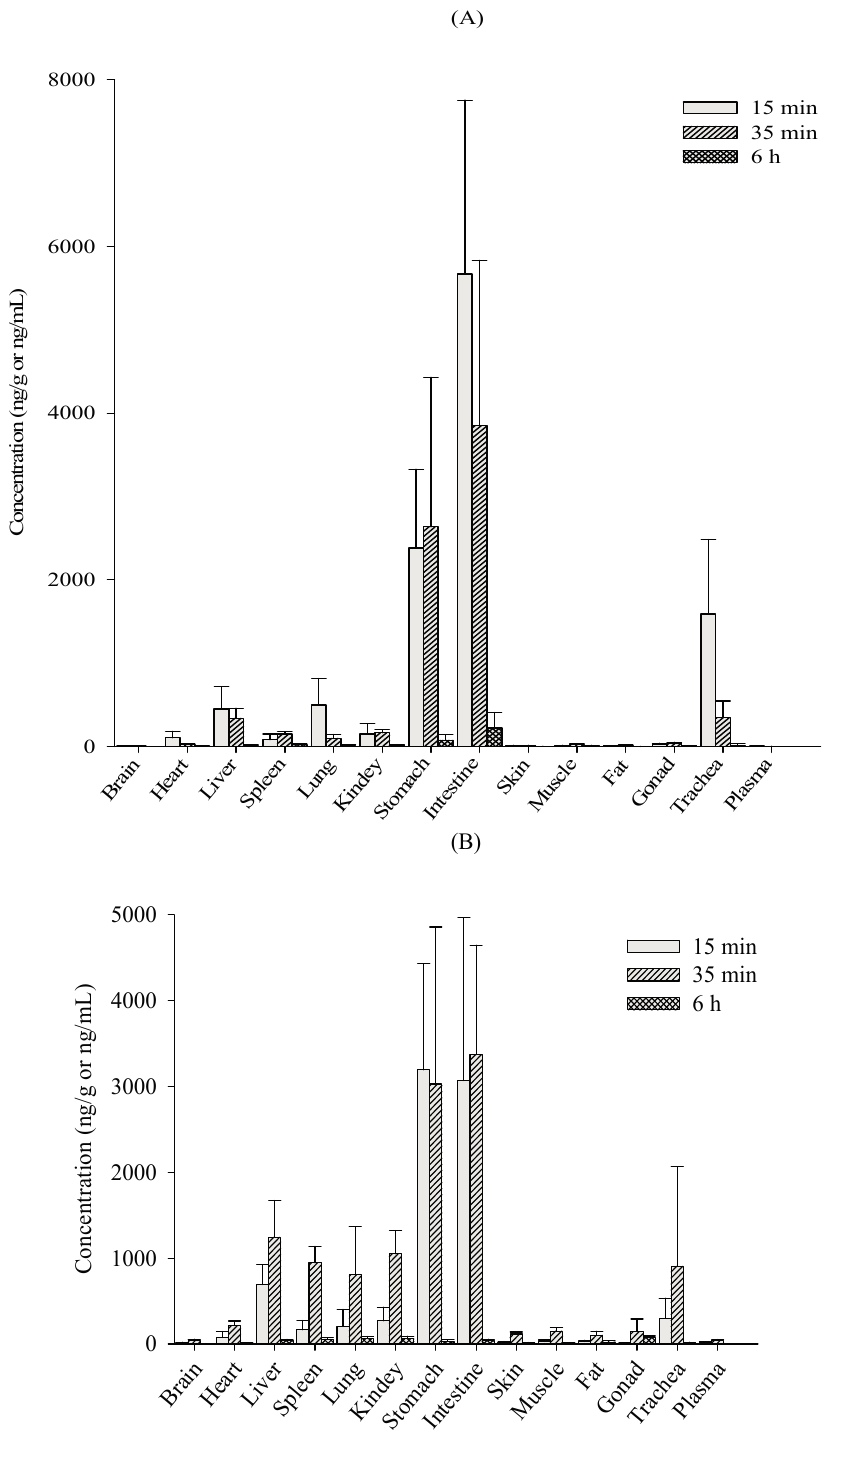
Figure 5. Tissue distribution of verticinone at 15 min, 35 min and 6 h following i.g. administration of 2 mg/kg to rats ( n = 5). ( A ) female; ( B )